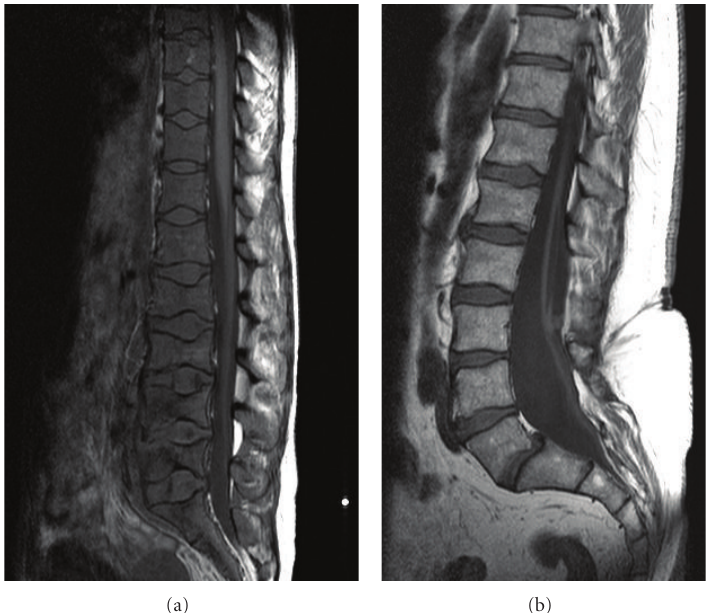
Figure 1: (a) shows a T1W sagittal MRI spine of a patient with sickle cell anaemia with di ff use low signal from the vertebral bodies consistent with hyperplastic haematopoietic red marrow replacing the normal bright fatty marrow. Note smooth concavity of the vertebral endplates at multiple levels from bone softening (fish mouth vertebra). Normal appearance of marrow is depicted on (b) for comparison.